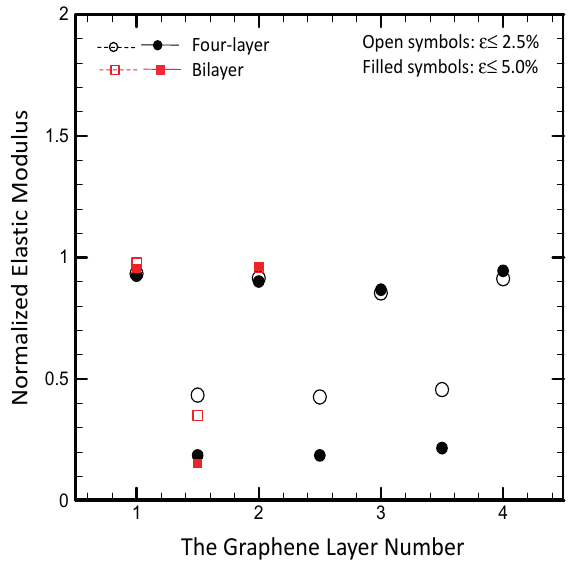
Figure 18. The normalized second-order elastic modulus of each graphene layer ( E corresponds to integer layer number) and interlayer interaction strength ( E the points at fractional layer number) in FLG, where E monolayer ( n =